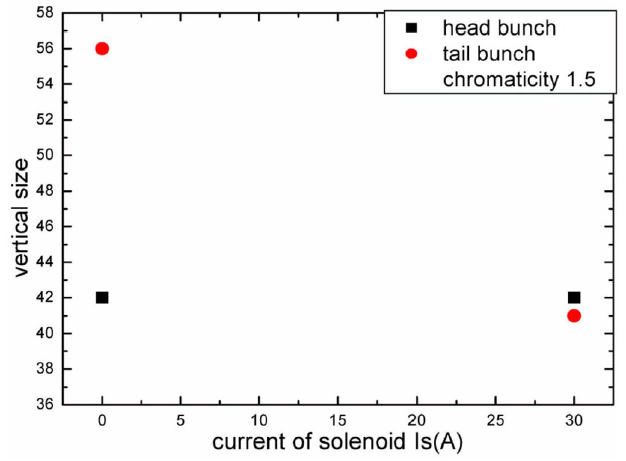
FIG. 28. (Color) Vertical beam size of the first and last bunch in a train as a function of the solenoid strength at BEPC in 2004 [38]; the beam size was measured by a streak camera.